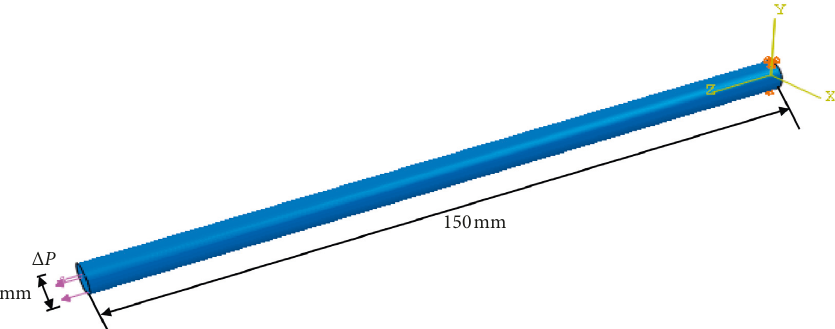
Figure 10: The geometry model of the undamaged steel wire.